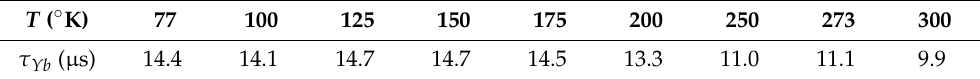
Figure 2. Dependence of the Yb emission intensity as a function of the temperature for a 5.3 × 10 − 5 M solution of YbL in D 2 O containing 12% glycerol ( λ exc = 270 nm). Table 1. Ytterbium lifetime in the range of 77–300 K (YbL = 5.3 × 10 − 5 , D 2 O with 12%